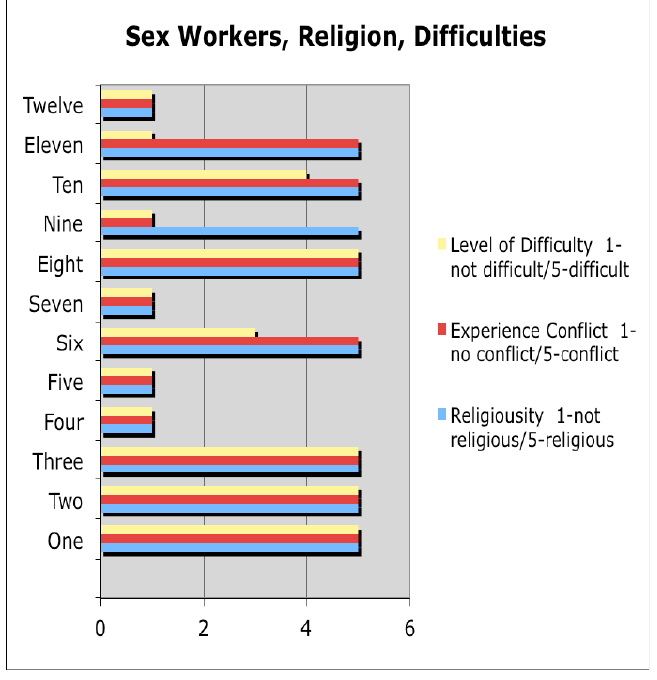
Figure 1. Comparison of the level of religiosity, conflict, and difficulties as reported by